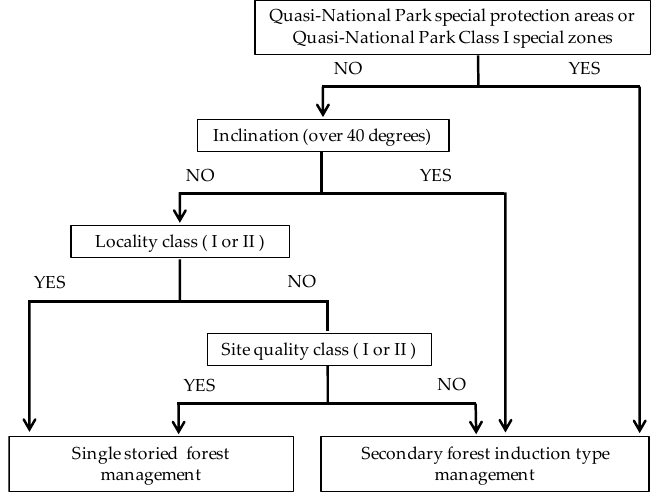
Figure 3. High impact forestry plan (Plan 1).